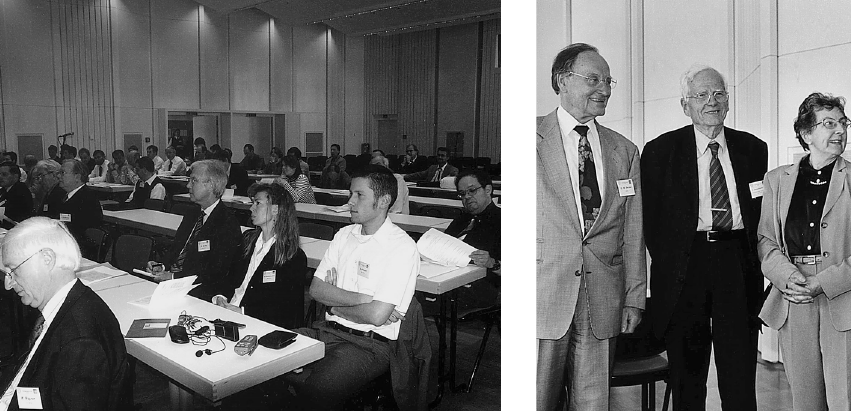
Figure 5 (left below): A glance at the audience. Figure 7 (right below): Prof. Becker,